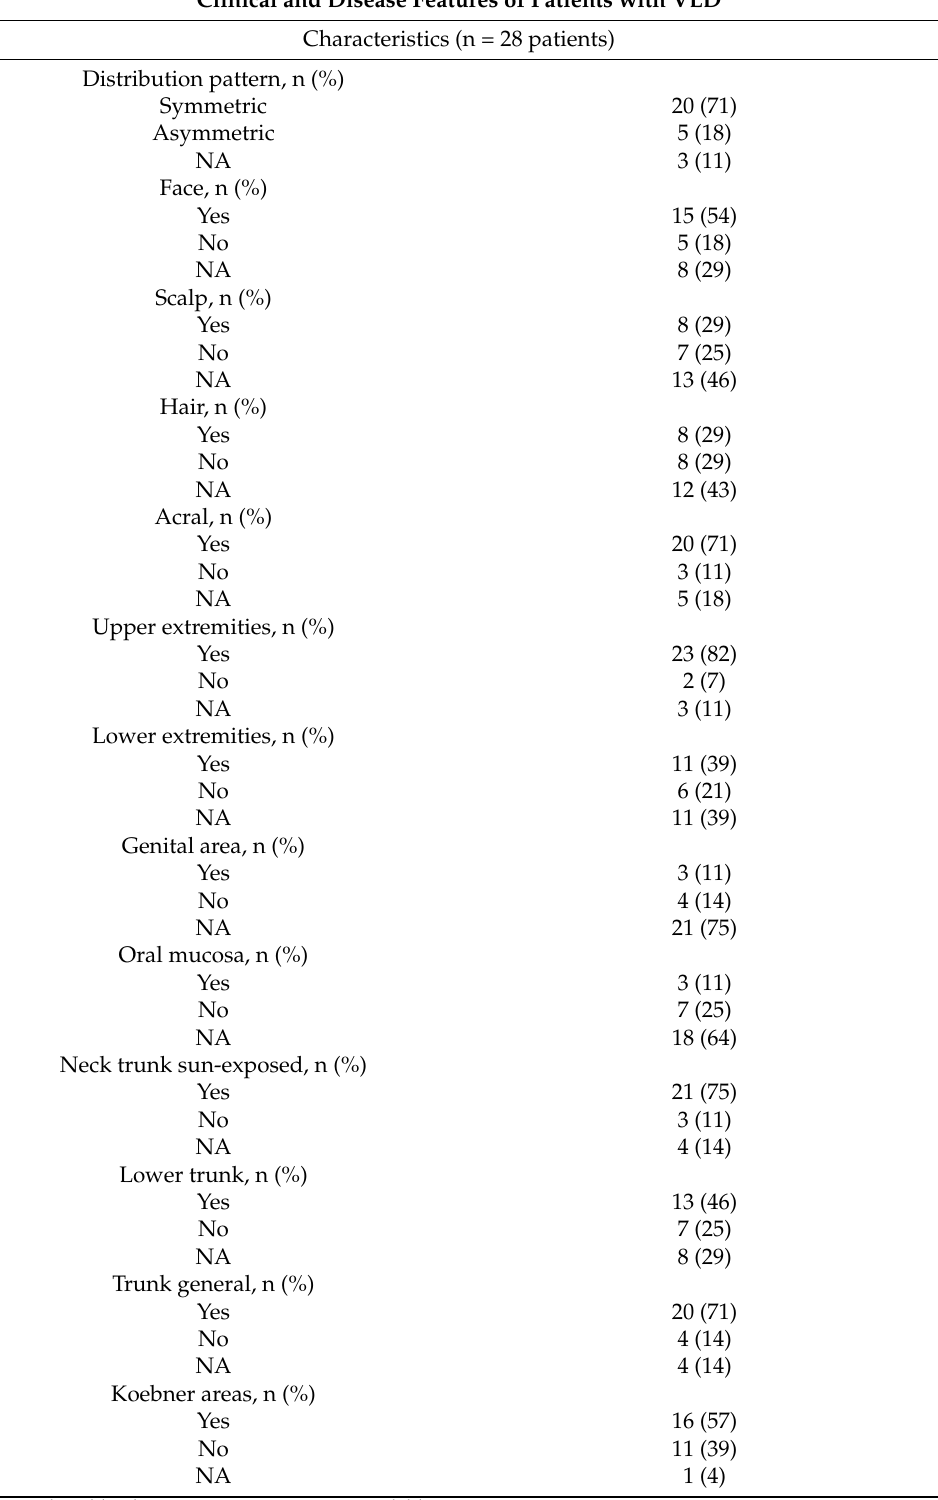
Table 2. Distribution of VLD skin lesions and clinical features: Analysis of the distribution and appearance of the depigmented